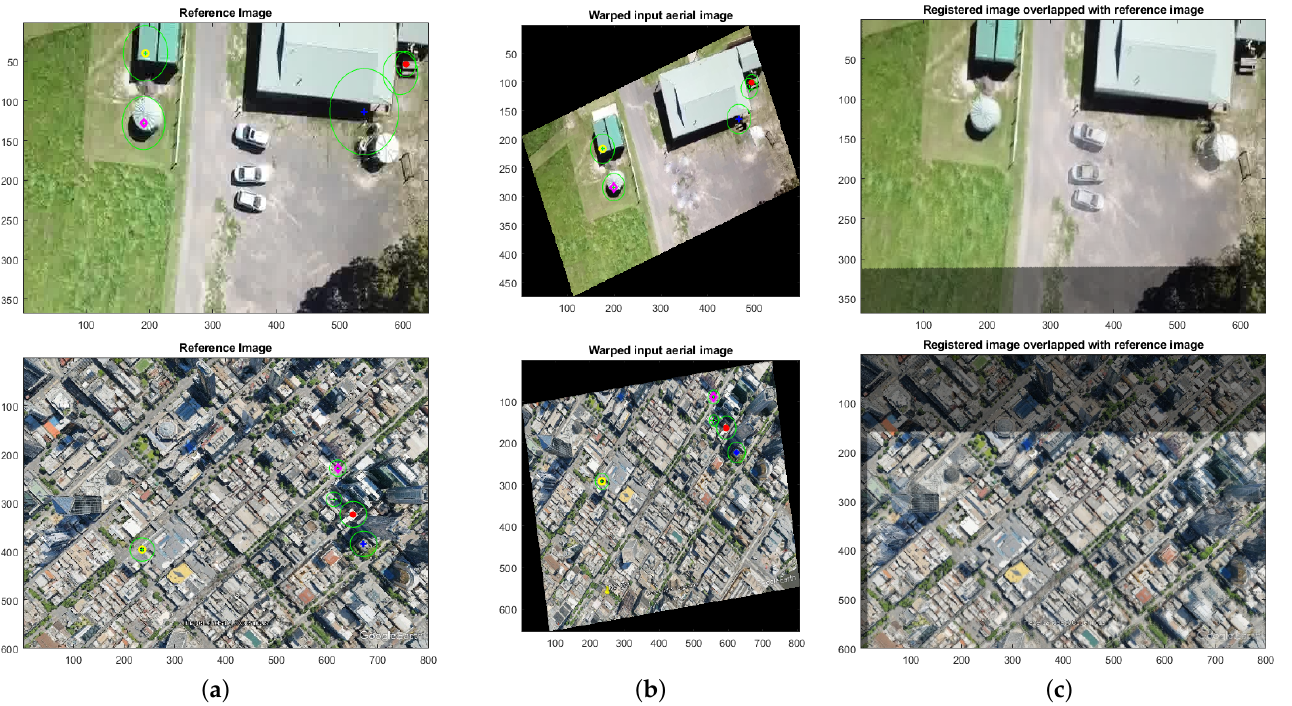
Figure 3. Performance of the registration algorithm implemented in this work. Column ( a ): reference images. Column ( b ): Aerial images taken by UAV whose scenes are partially identical to those of reference images. Column ( c ): registration results, where the registered images are on top of the corresponding reference images. The first five significant feature points, which can be distinguished by colour, are marked in both the reference images ( a ) and aerial images ( b ).